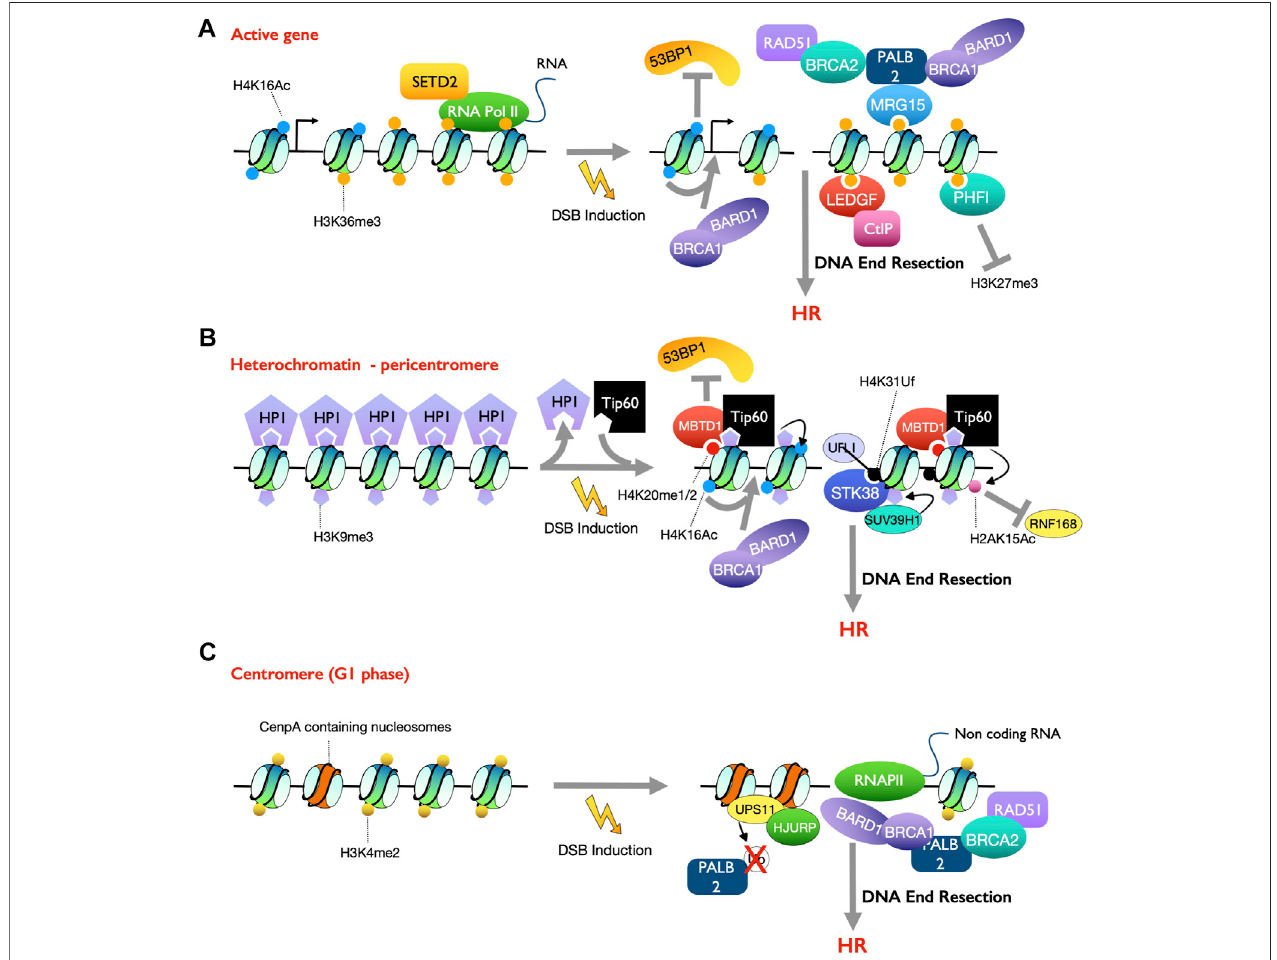
FIGURE2| SummaryofdifferentchromatinenvironmentsthatpromoteDSBrepairbyHR. (A) Ineuchromatin,transcriptionallyactivehistonemarkH3K36me3and H4K16ac promote DSB repair by HR (B) At peri-centromeric heterochromatin, histone repressive mark H3K9me3 interacts with Tip60 to acetylate H4K16 to attenuate 53BP1 recruitment. MBTD1, a subunit of Tip60/NuA4 complex, competes with 53BP1 form H4K20me1/2 to promote HR repair. Upon DSB induction, UFL1 mediates ufmylation on H4K31, which recruit histone lysine methyltransferase SUV39H1 to increase H3K9me3 and thereby promote HR (C) At centromeres in G1 phase, H3K4me2promotesnon-codingRNAtranscriptionandRNA-DNAhybridsformation,whichrecruitsHRfactorstoDSBs.Thecentromerespeci fi chistonevariantCENP- A promotes the recruitment of Rad51 for HR repair. The deubiquitylase USP11 stabilizes CENP-A chaperone HJURP and PALB2 to recruit RAD51 and BRCA1, respectively, for HR